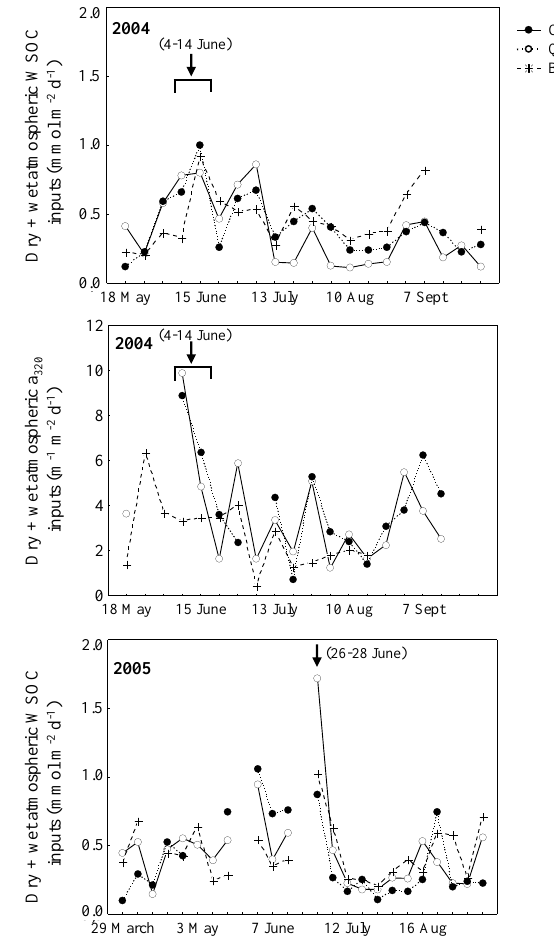
Fig. 2. Synchronous dynamics of water-soluble organic C (WSOC, mmolm − 2 d − 1 ) and its absorption coefficient at 320nm ( a 320 m − 1 m − 2 d − 1 ) in the three collectors during the study peri- ods of 2004 and 2005. The arrows point to relevant Saharan dust intrusions during the study periods (see also Fig. 3 for the aerosol index